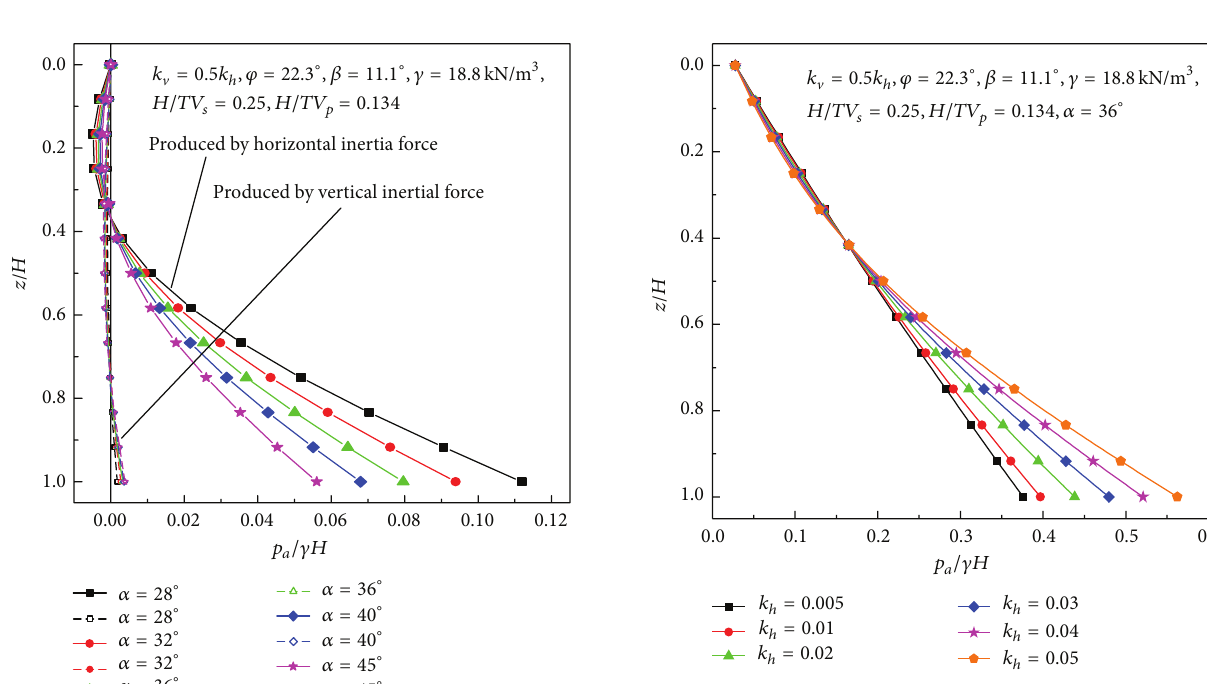
Figure 7: Active earth pressure distribution for different values of 𝑘 = 0.5𝑘 𝑘 ℎ with 𝑉 ℎ .